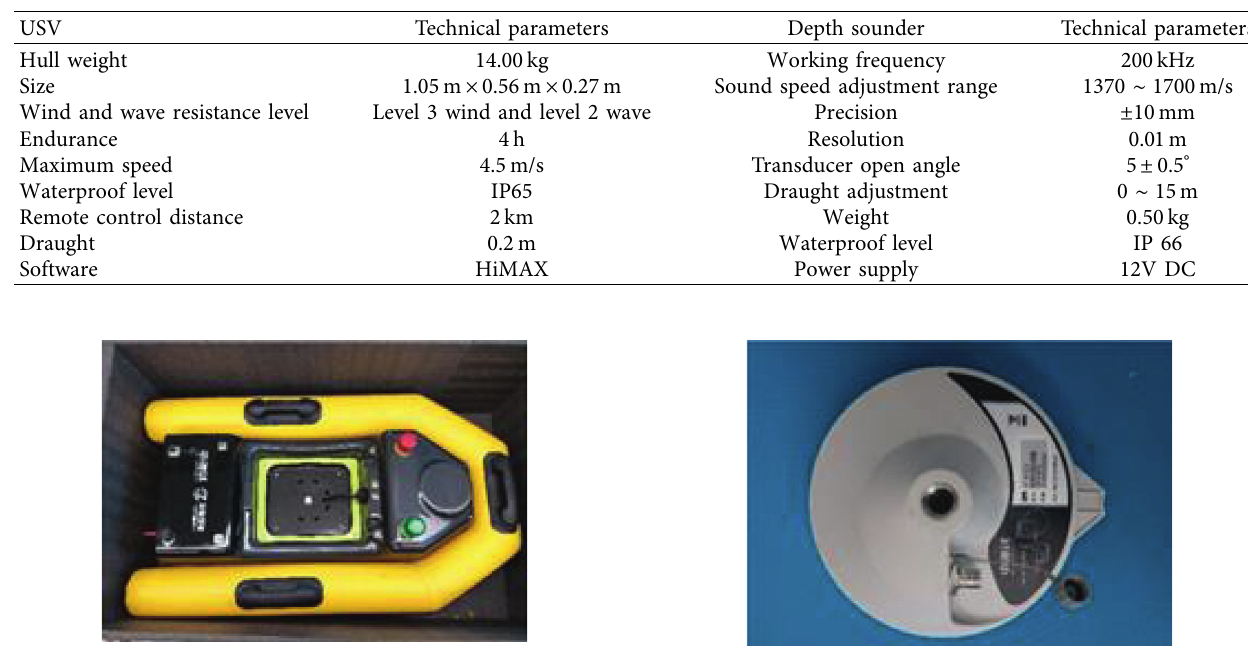
Table 1: The main parameters of USV and depth sounder.